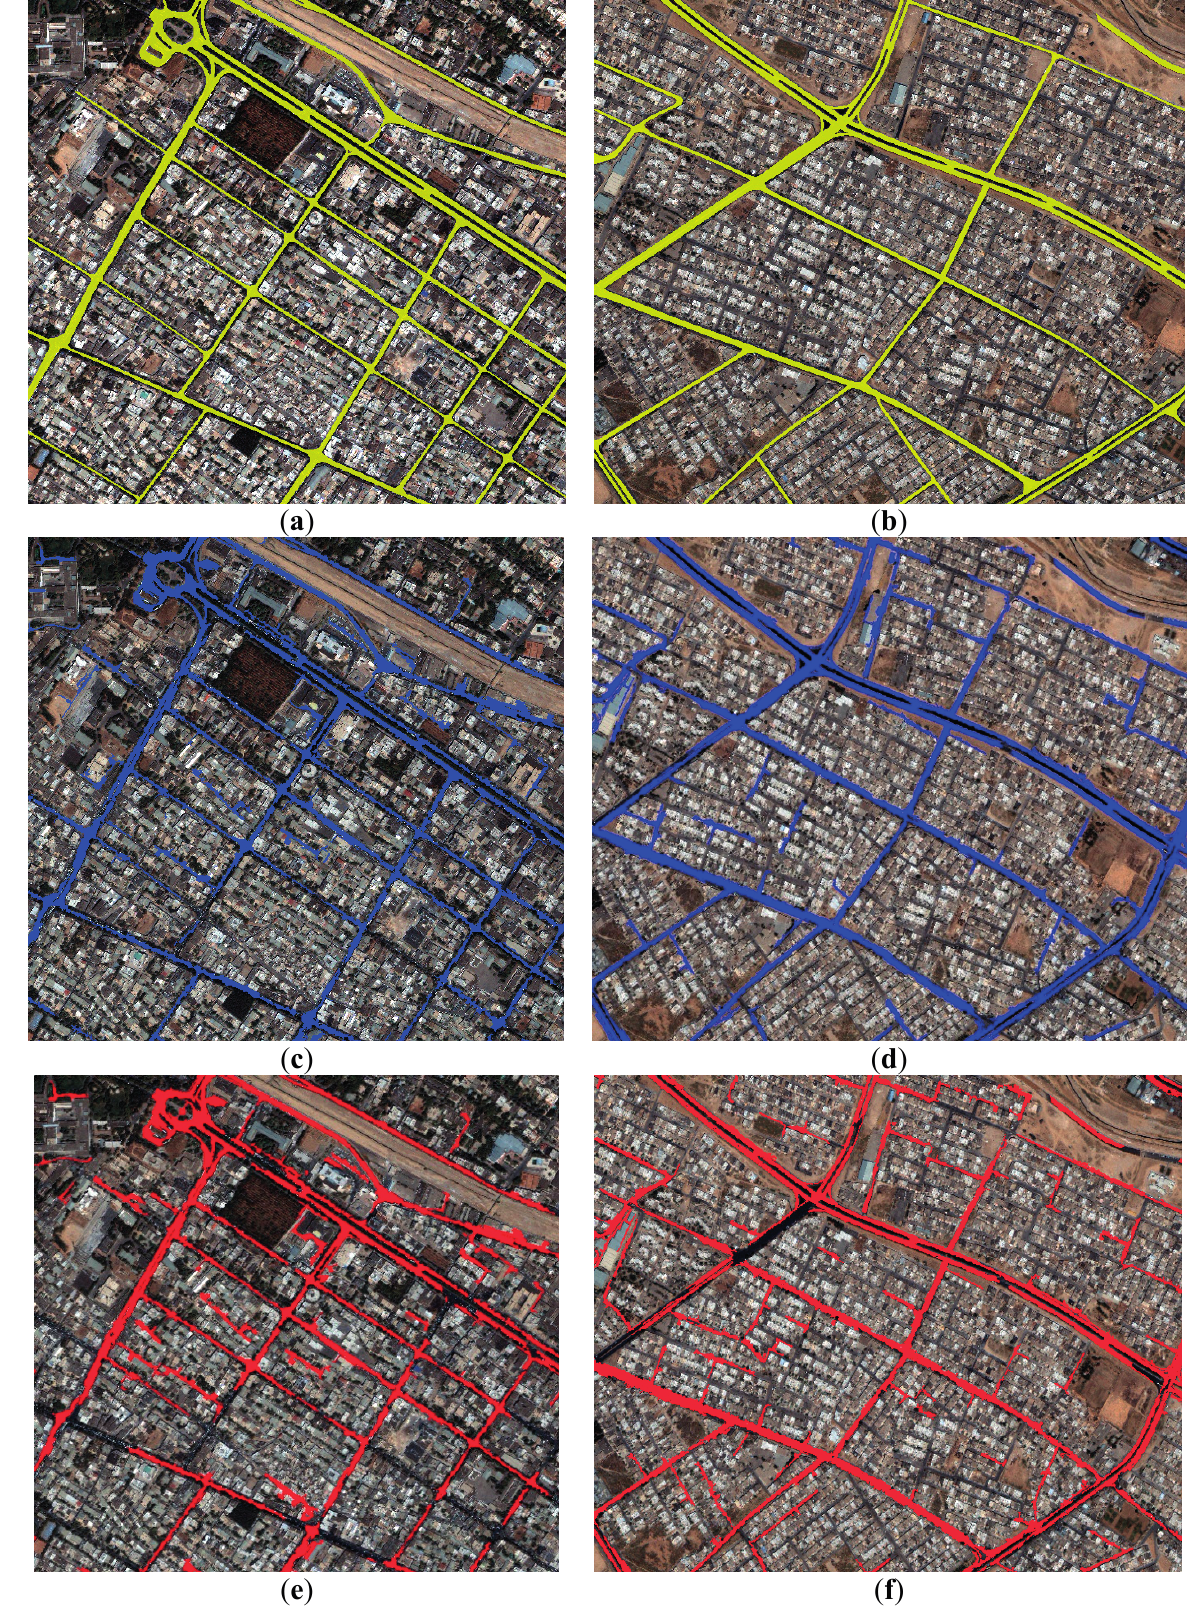
Figure 13. ( a,b ) The referenced road data of Hamadan 1,2 IKONOS images. ( c , d ) The final result of the proposed T2 FLS after enhancement. ( e , f ) The final result of T1 FLS after